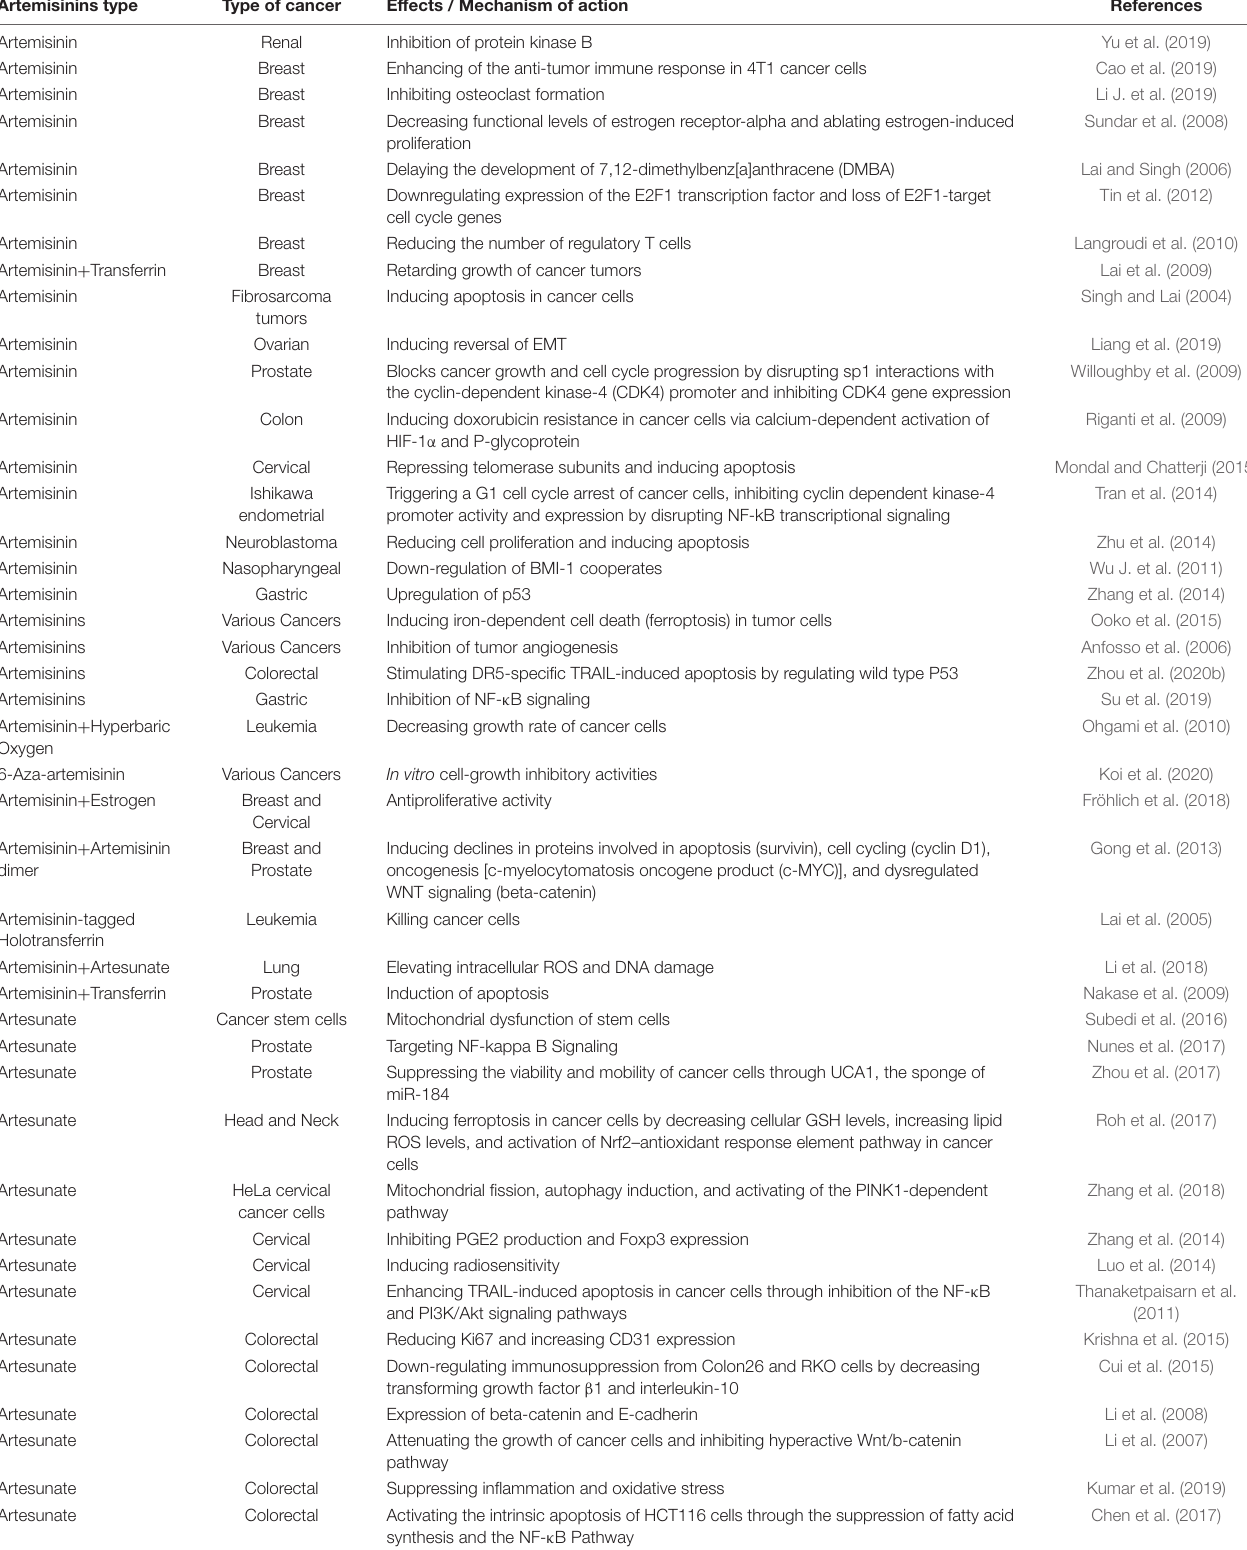
TABLE 1 | Artemisinins effects/mechanisms of action in combating various